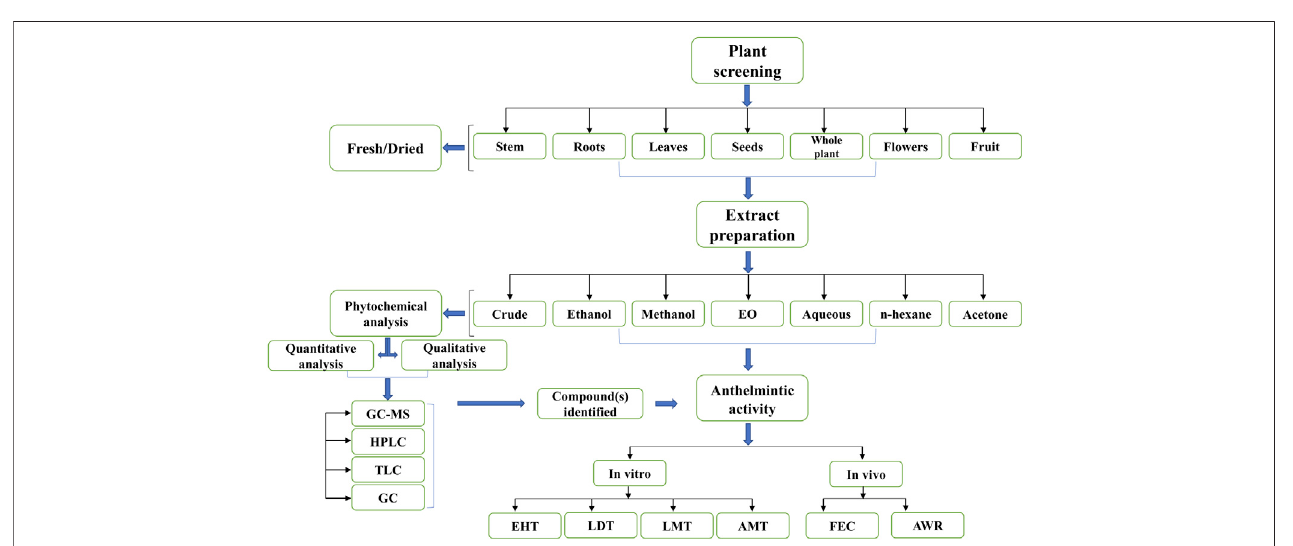
FIGURE 2 | Selection and processing of plant material(s) for anthelmintic evaluation.